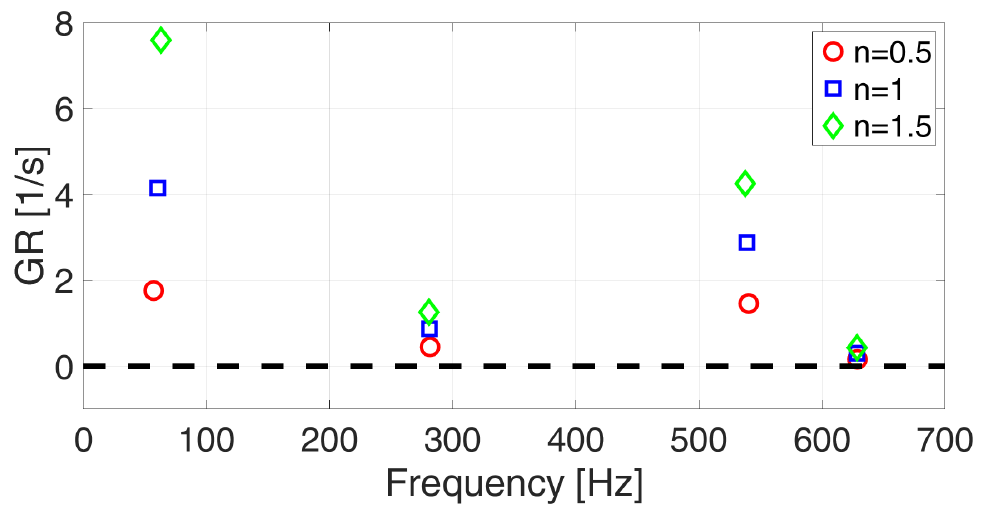
Figure 18. Sensibility analysis on the interaction index n for the H 2 –air